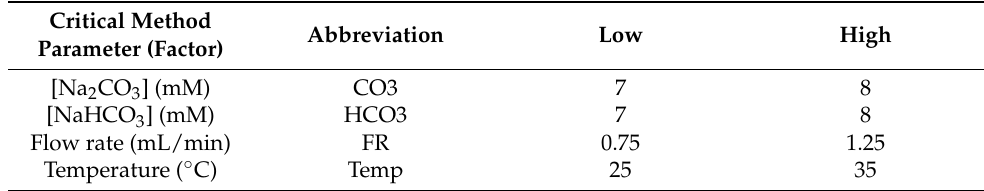
Table 2. Studied ranges of critical method